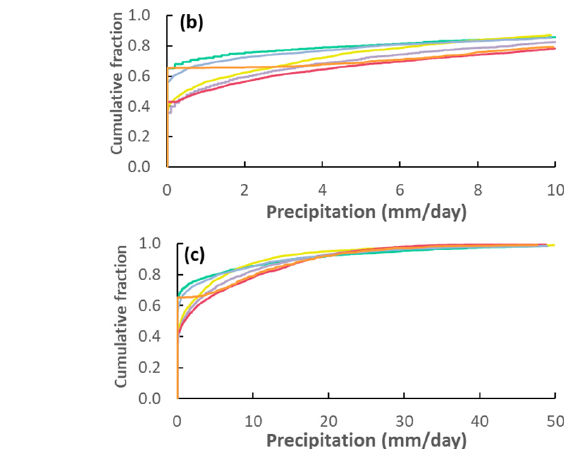
Figure 6. Distribution of daily precipitation values of the six precipitation inputs at PS-2: ( a ) distribution of all precipitation values; ( b ) distribution of precipitation < 10 mm; ( c ) distribution of 10 mm ≤ precipitation ≤ 50 mm.